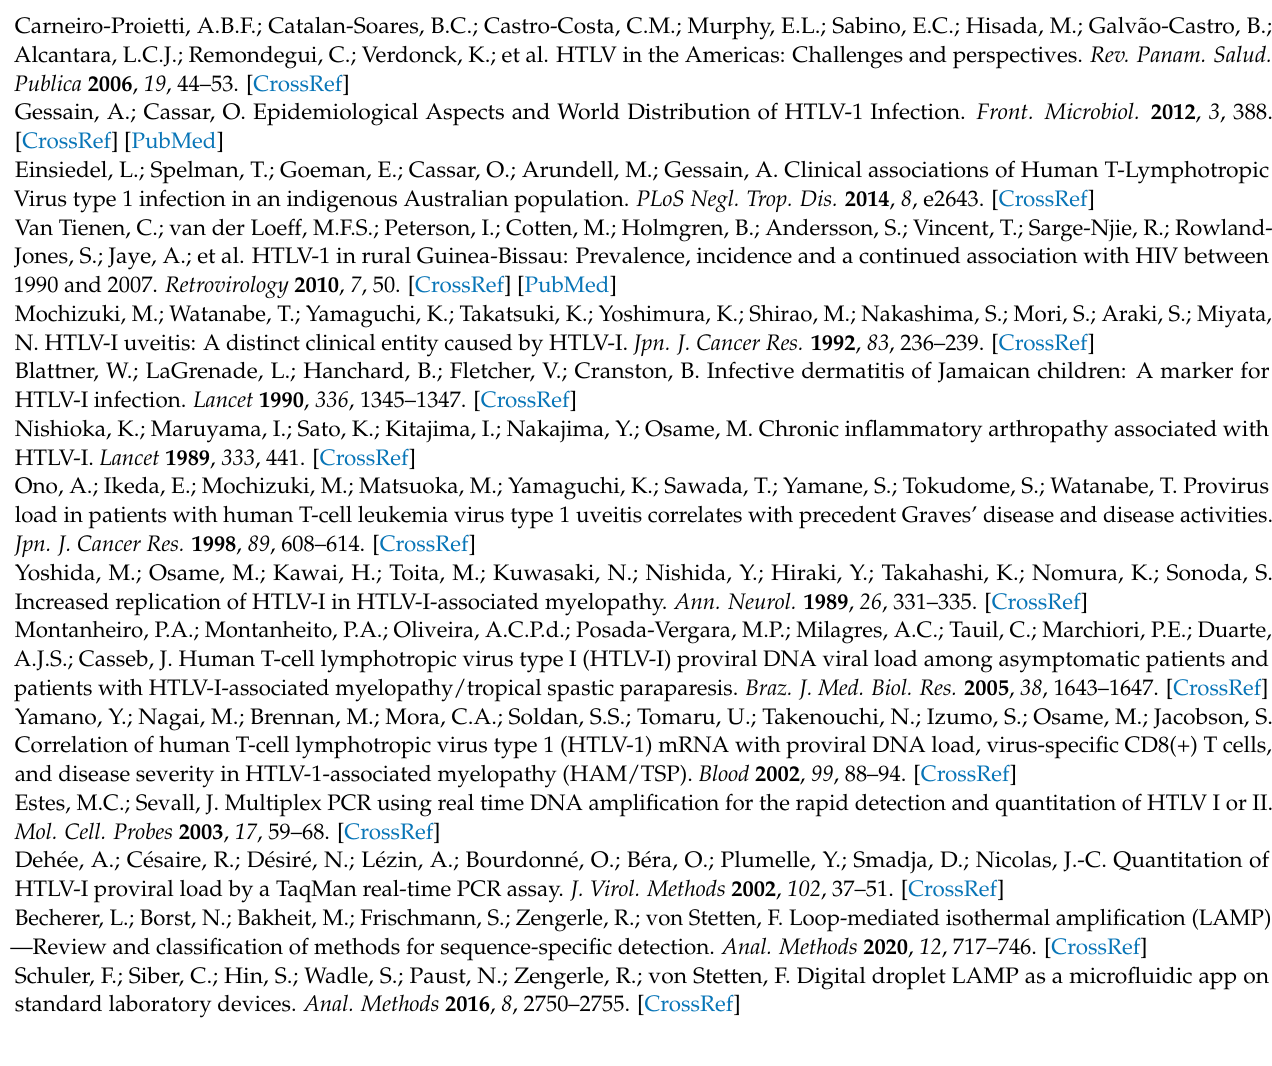
droplet generation; Figure S5: Stroboscopic image of the generated droplets; Figure S6: Layout of the microfluidic